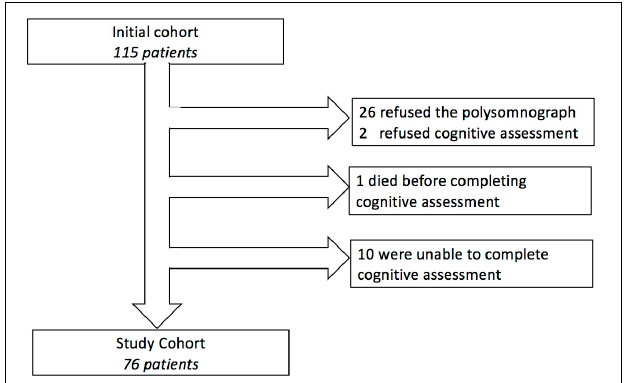
FIGURE 1 | Flowchart of patient inclusions and